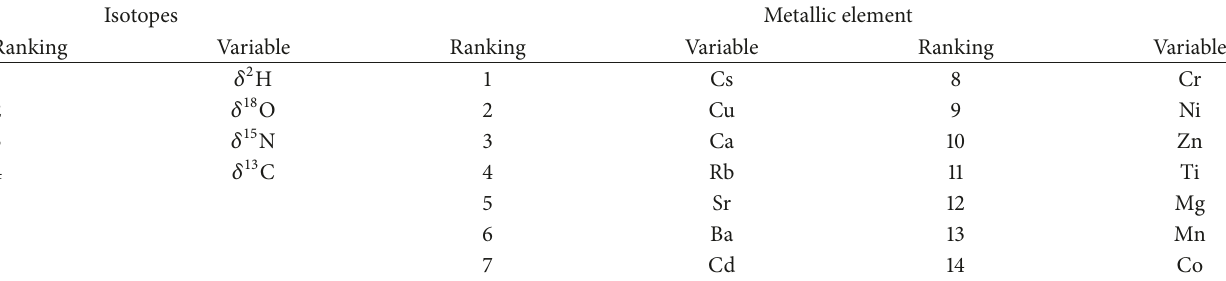
Table 7: Rank results of isotope and metallic element data